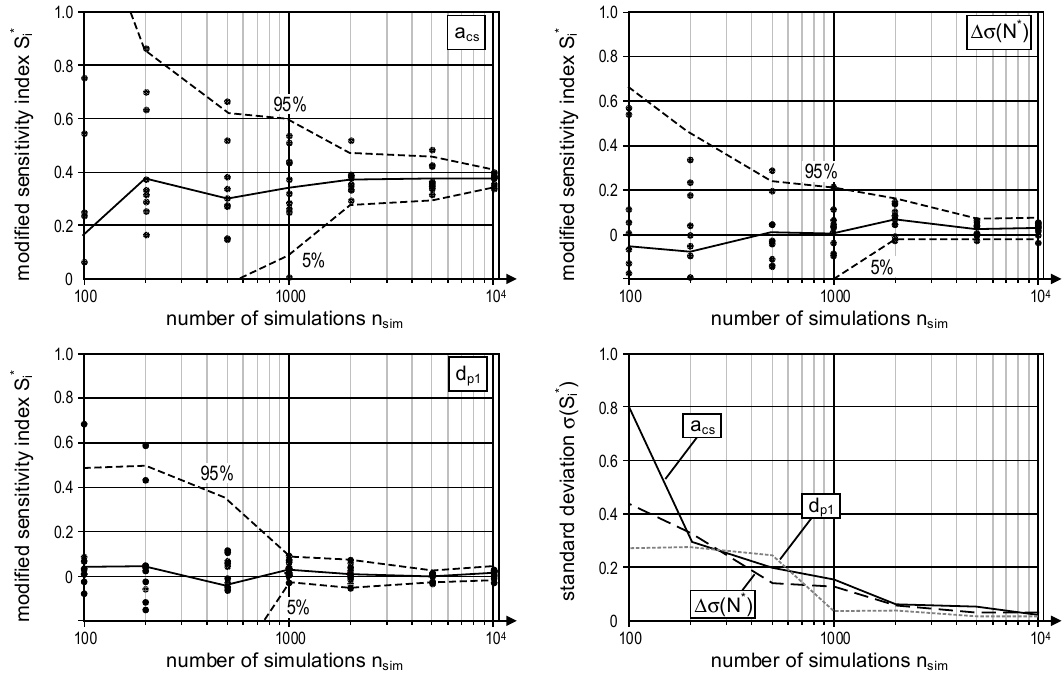
Figure 9. Convergence of the modified sensitivity index for three parameters of the lifetime prediction model.